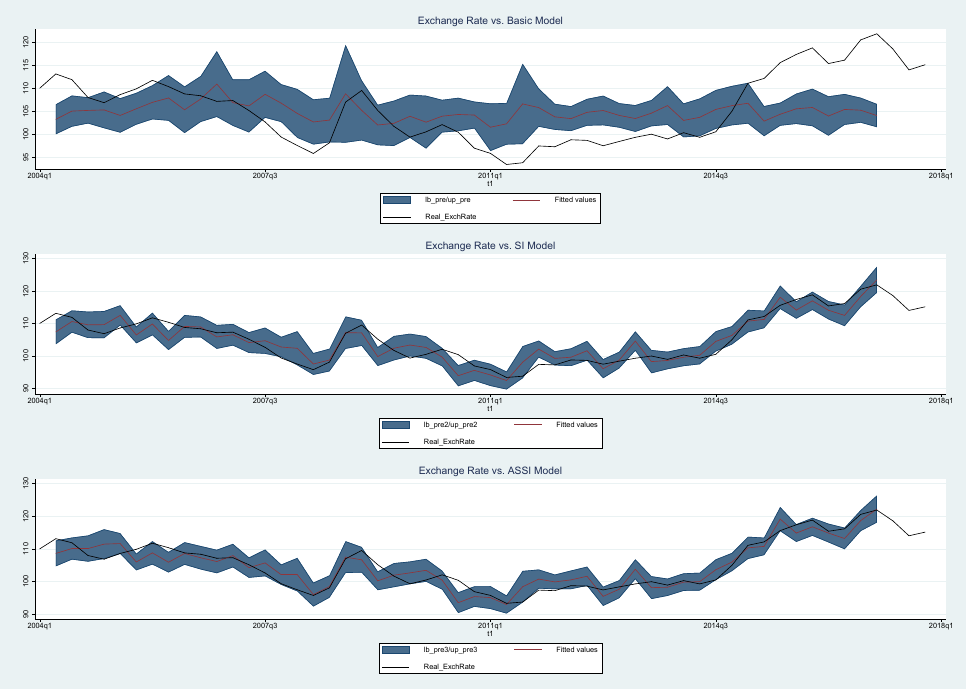
Figure A3. US—Exchange Rate